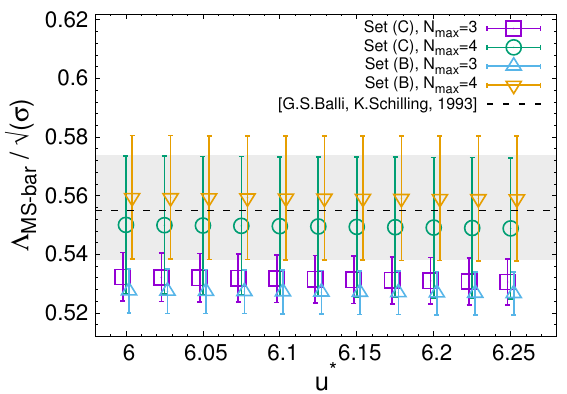
p = (cid:27) . The MS